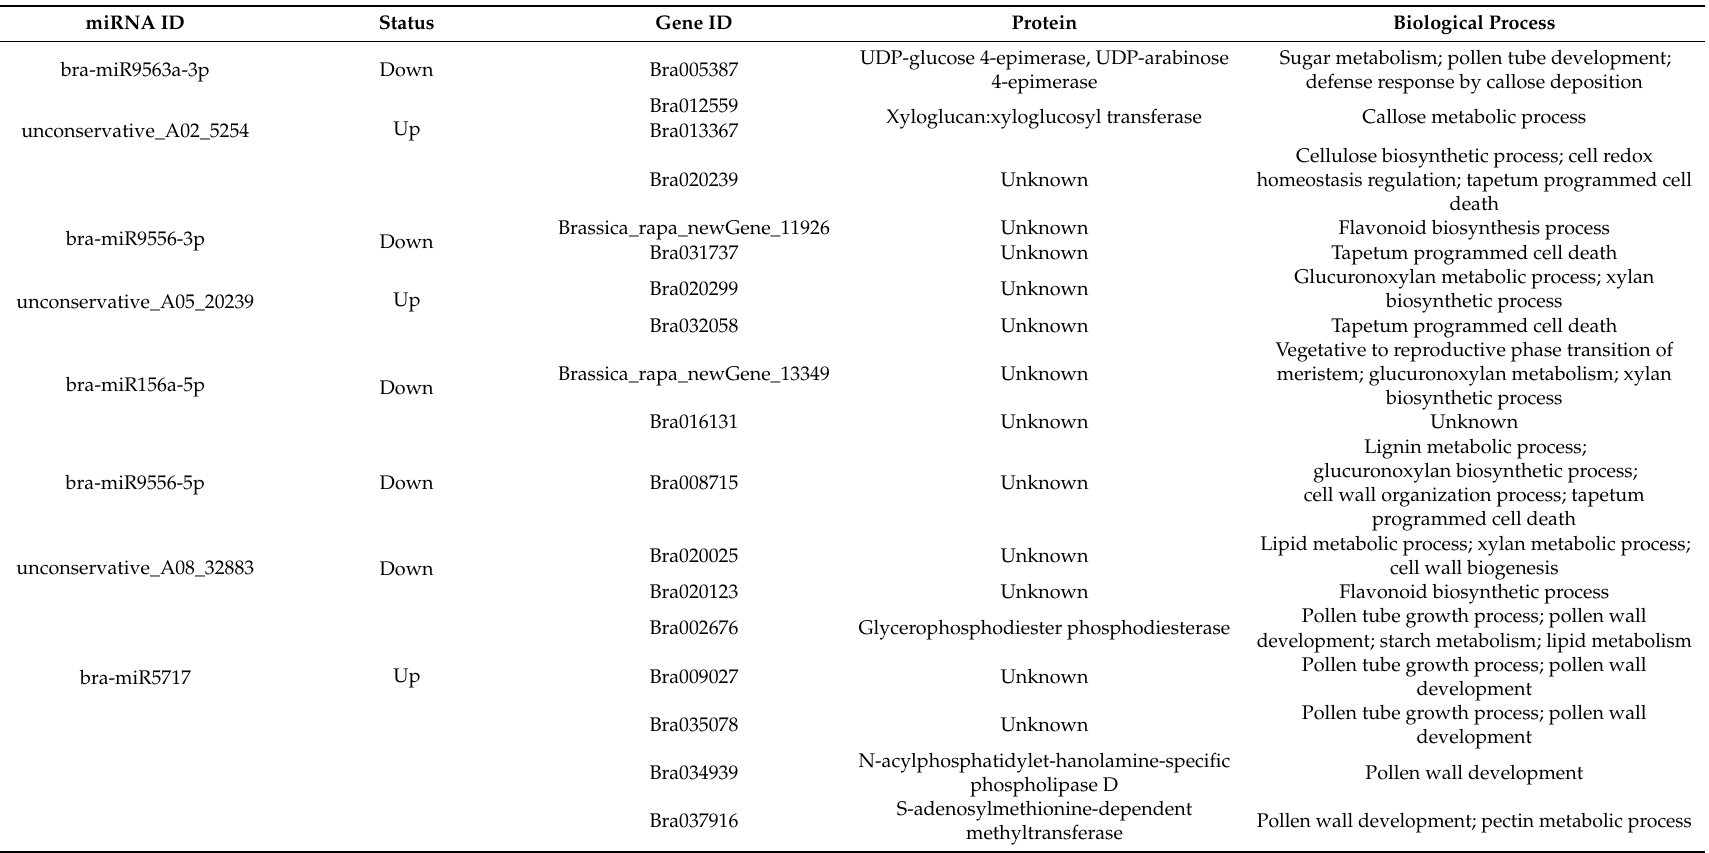
Table 6. Di ff erentially expressed miRNAs and their target genes in the DEmiRNA–DEmRNA network involved in anther development in Bcajh97-01B (fertile line) and Bcpol97-05A (sterile line) of Brassica campestris